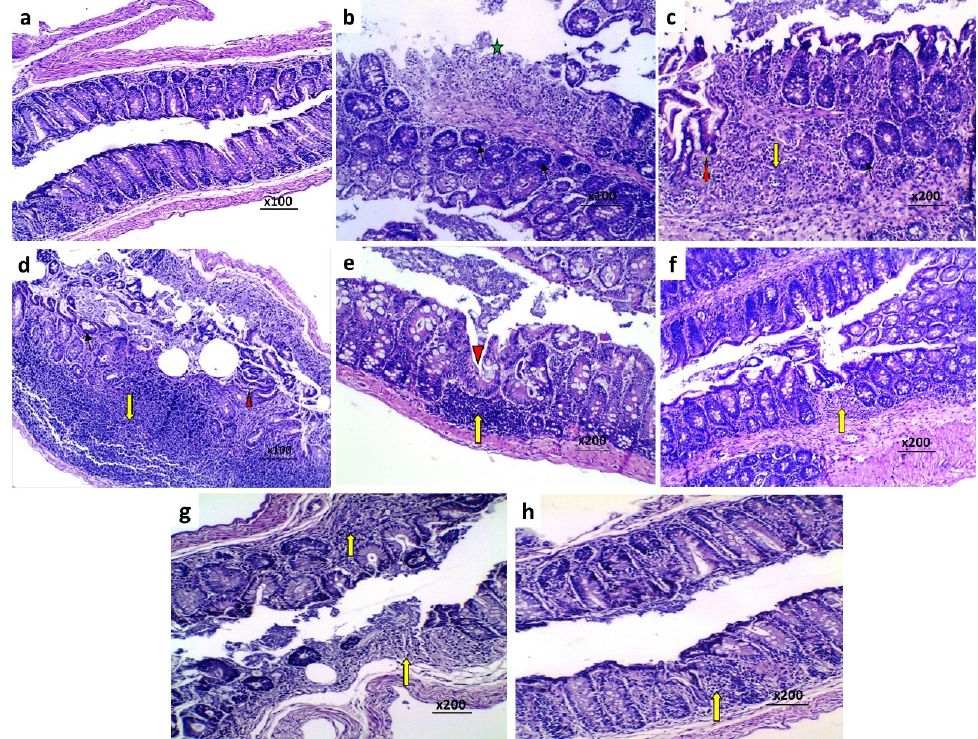
Figure 5. Hematoxylin and eosin stained sections of the colon of ( a ) The control untreated mice showing normal mucosa with intact mucosal glands, normal distribution of goblet cells and normal crypts (H and E ×100); ( b ) DSS mice showing surface ulceration of the colonic mucosa (Astrex) (×100); ( c ) DSS mice showing partial loss of the goblet cells (Thin arrow) with disruption of the crypts (Arrow head) (×200); ( d ) DSS mice showing massive inflammatory cellular infiltration mainly by lymphocytes (Thick arrow) (×400); ( e ) DSS mice treated with CMC showing disruption of the mu- cosal crypts (Arrow head) and inflammatory cellular infiltration mainly by lymphocytes (Arrow) (×200); ( f ) DSS mice treated with perindopril showing attenuated histological damage of the colonic tissues with minute ulcerations of the colonic mucosa and significant decrease in the inflammatory cellular infiltration (Arrow) (×200); ( g ) DSS mice treated with ambrosin showing significant amelio- ration of the histopathological damage of the colonic tissues with smaller ulcerations of the colonic mucosa and less dense inflammatory cellular infiltration (Arrows) (×200); ( h ) DSS mice treated with perindopril/ambrosin combination exhibiting restoration of the normal architecture of the colonic mucosa with absence of ulceration and mild inflammatory cellular infiltration (Arrow) (×200).